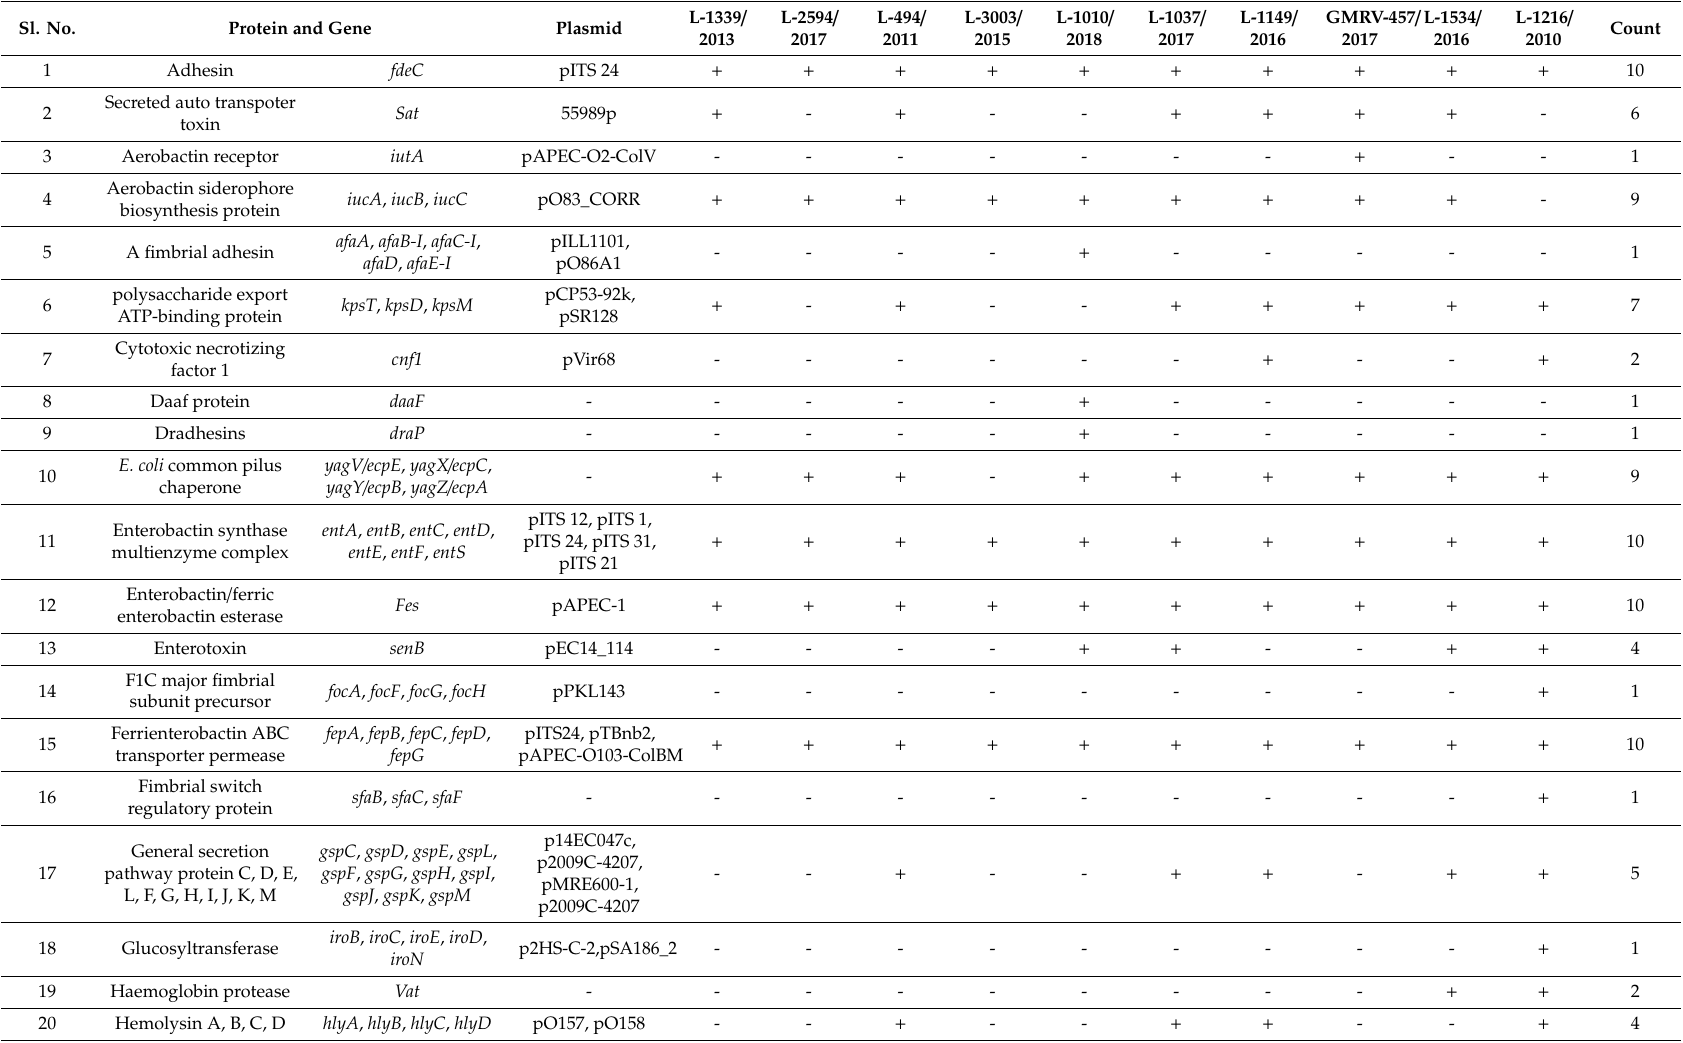
Table 5. Virulence genes * in 10 ocular E. coli